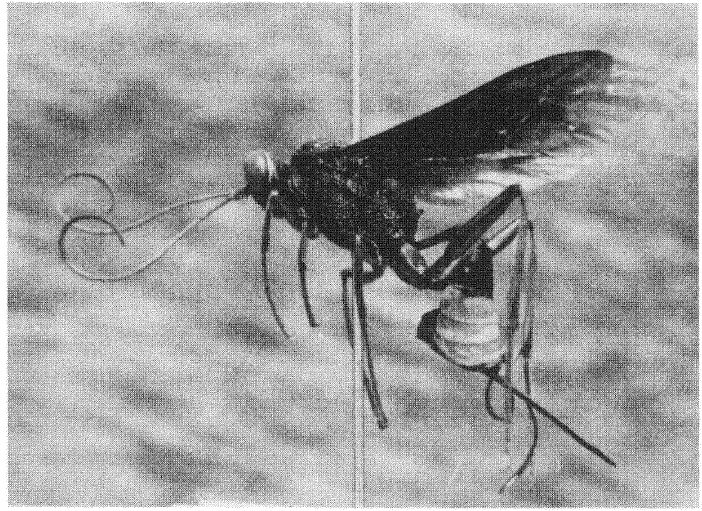
Fig. 5. Cosmiocryptus leucetrum, lateral